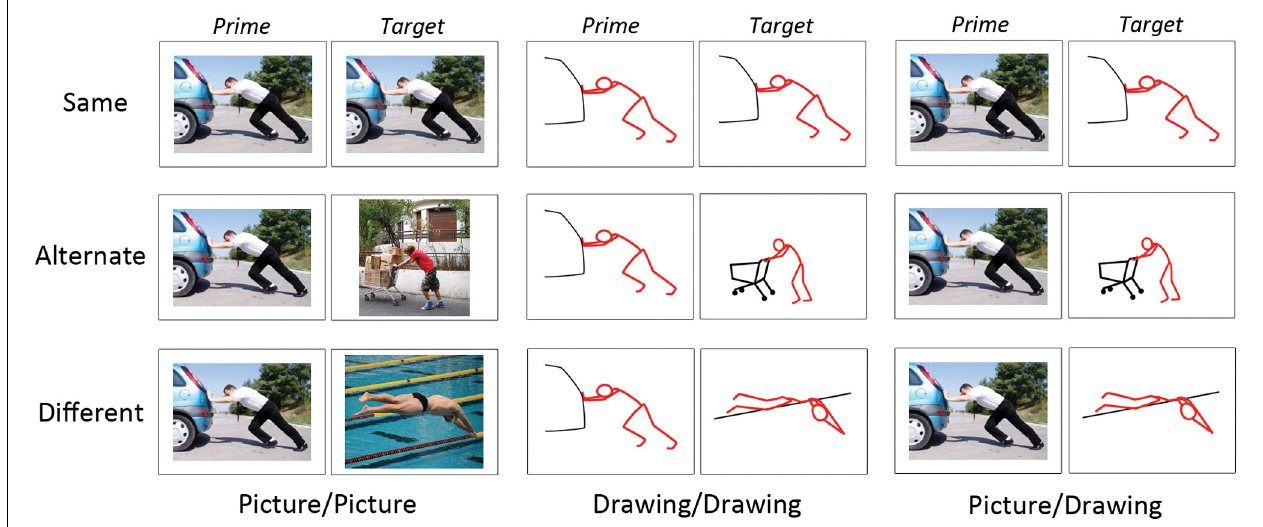
FIGURE 1 | Examples of experimental stimuli. Each trial consisted of a prime and target image presented in succession. Images on “Same” trials depicted the same instance of the same action. Images on “Alternate” trials depicted different instances of the same action. Images